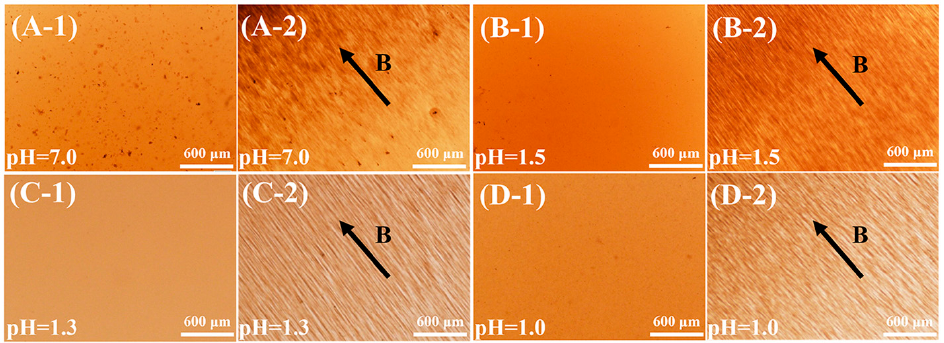
Figure 8. Optical microscope images of the samples ( A-1 – D-1 ) without the magnetic field and ( A-2 – D-2 ) with a magnetic field. (The B shows the direction of the magnetic field).